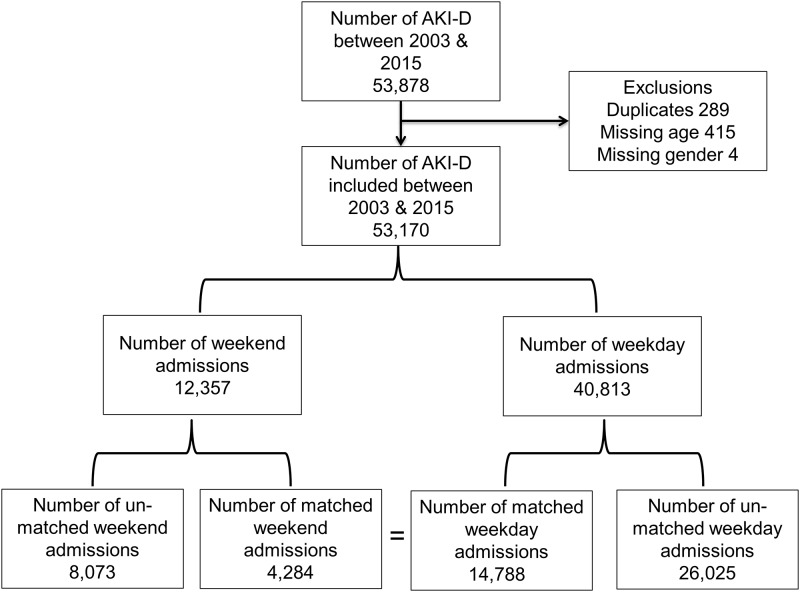
Study flow chart.